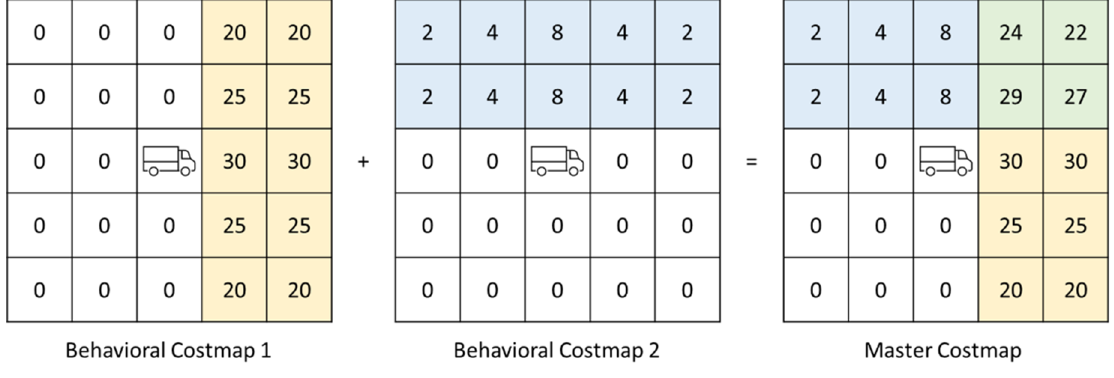
Figure 7. Simplified example of 5 × 5 behavioral costmaps, combined into a master costmap via addition.